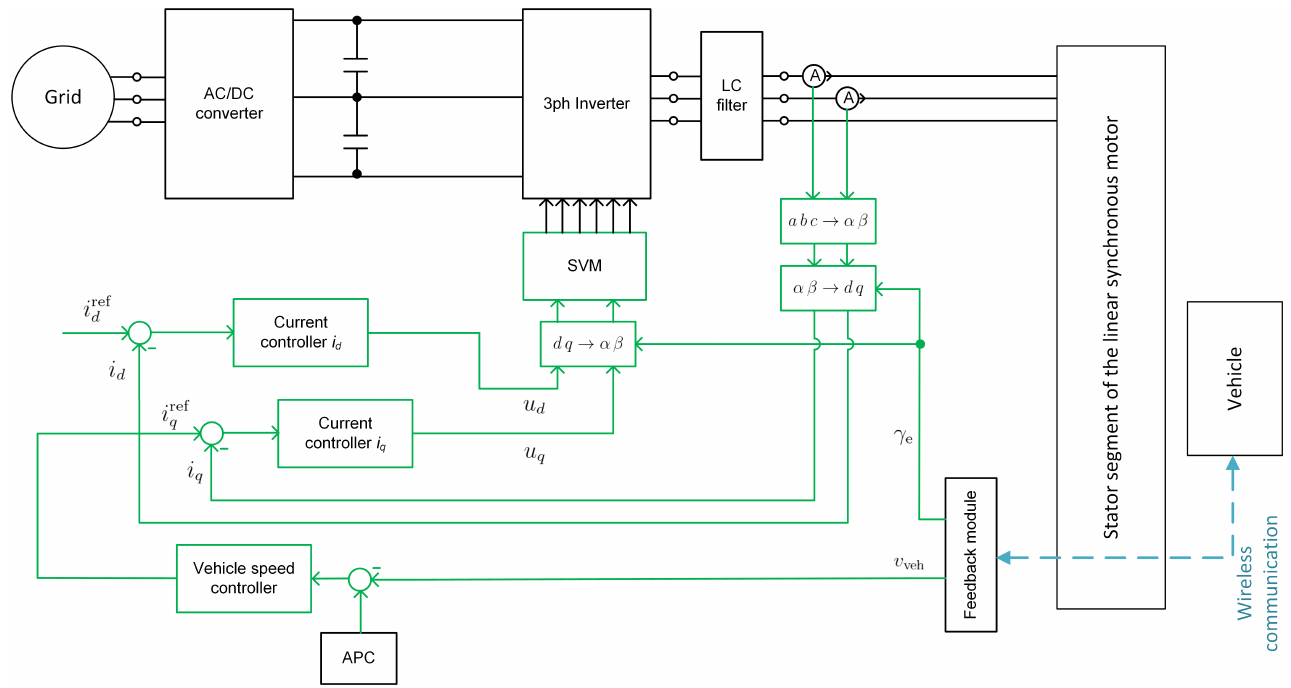
Figure 17. Block diagram of the control structure. Table 2. Power electronic set-up